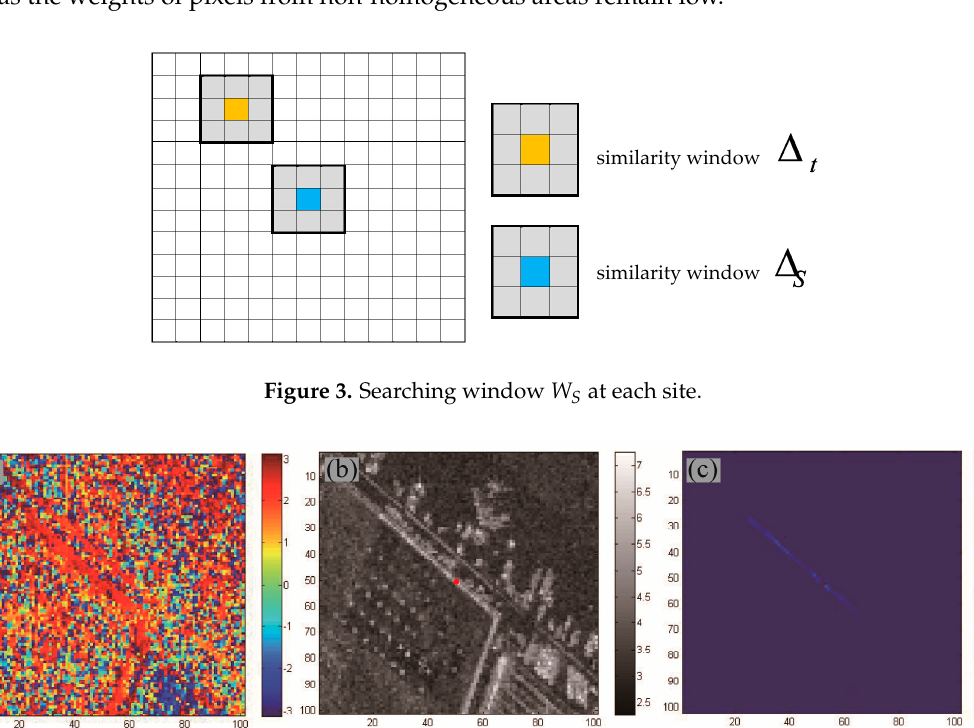
Figure 4. Similarity measurement: ( a ) noisy interferogram; ( b ) corresponding intensity, where the test pixel is marked by the red point; and ( c ) similarity measurement results.